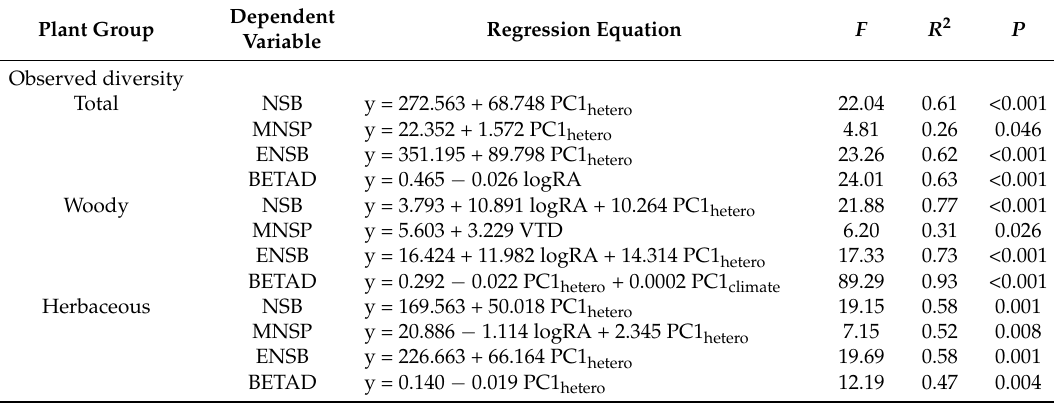
Table 4. Results of forward stepwise multiple regression models for the explanatory variables and diversity indices of total, woody and herbaceous plants along the ridge of the Baekdudaegan Mountains, South Korea. Tables 2 and 3 describe the abbreviations for explanatory variables and diversity indices. Rarefied diversity was calculated with the same sample size ( n = 26) in each elevational